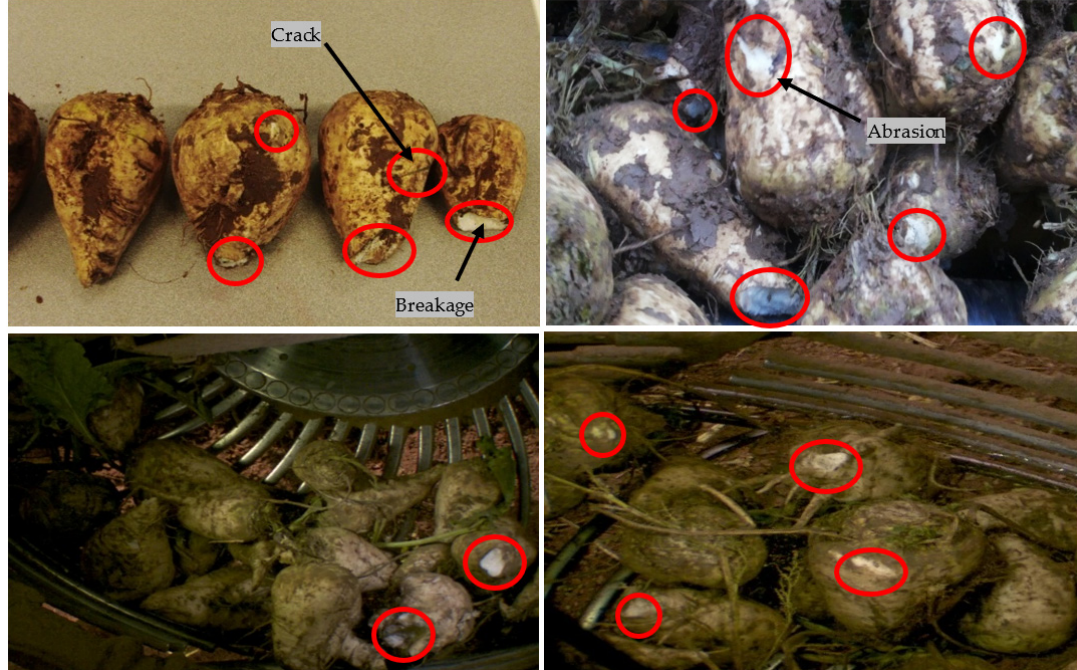
Figure 3. Examples of damage used for development of the CNN